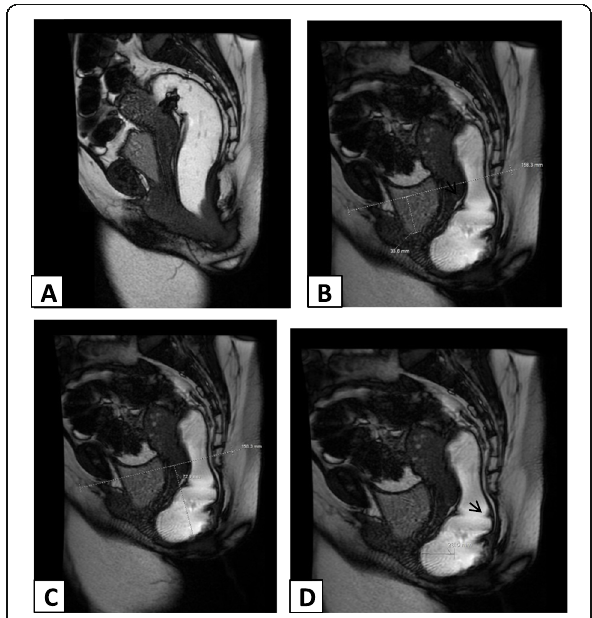
Fig. 2 Mid-sagittal SSFP obtained ( a ) at rest and ( b – d ) during defecation showing moderate cystocele (3.3 cm), severe rectal descent (7.2 cm), and moderate anterior rectocele (2.6 cm) with evidence of mucosal intussusception [arrow]